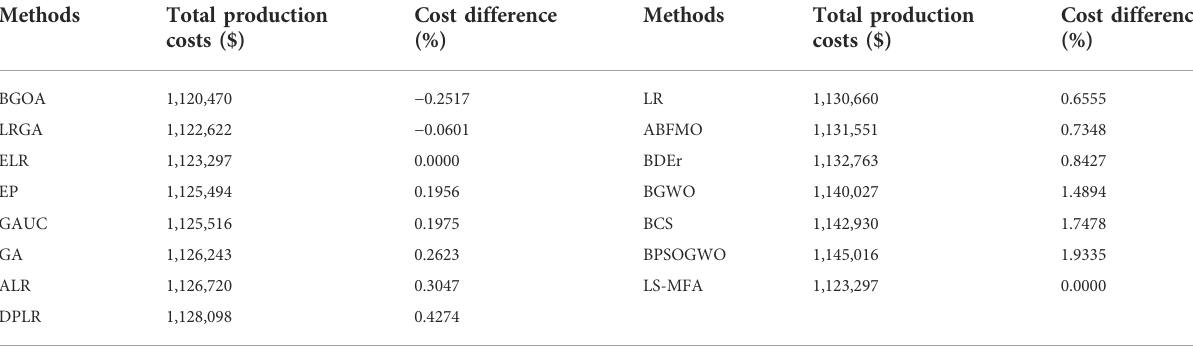
TABLE 6 Comparison of total cost with reported optimization techniques for 20-unit system.